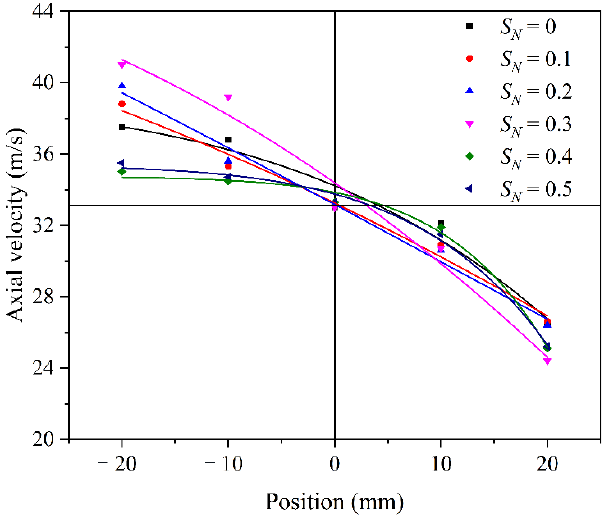
Figure 6. Axial airflow distribution and Gauss fitting under different swirl numbers.